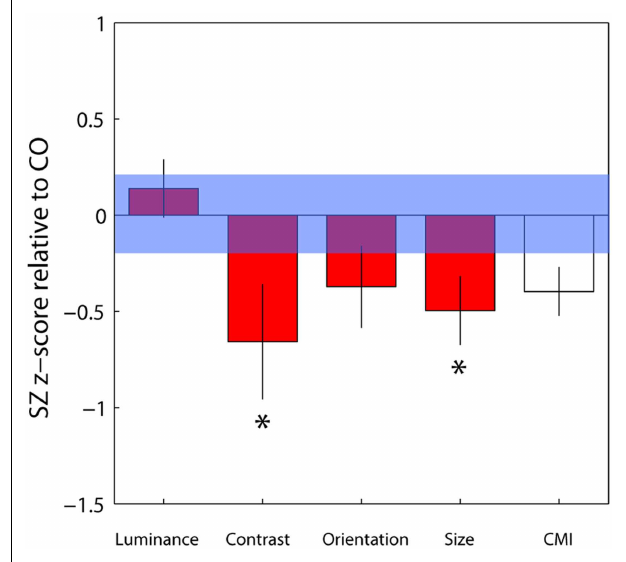
FIGURE 4 | Bias data from the schizophrenia group have been converted into z -scores relative to control group means and standard deviations for each of the four tasks, with individual parameter estimates weighted by their associated confidence interval. Negative and positive values, respectively, denote weaker and stronger contextual effects in the patient group. For each patient, a mean of these four standardized z -scores was calculated, generating a contextual modulation index (CMI) that represents a measure of general susceptibility to surround suppression (white bar). Error bars indicate the standard error of the mean (SEM) of the patient group; the blue shaded region indicates the SEM of the control group.*Significant effect at the 5% level following correction for multiple comparisons and single-tailed